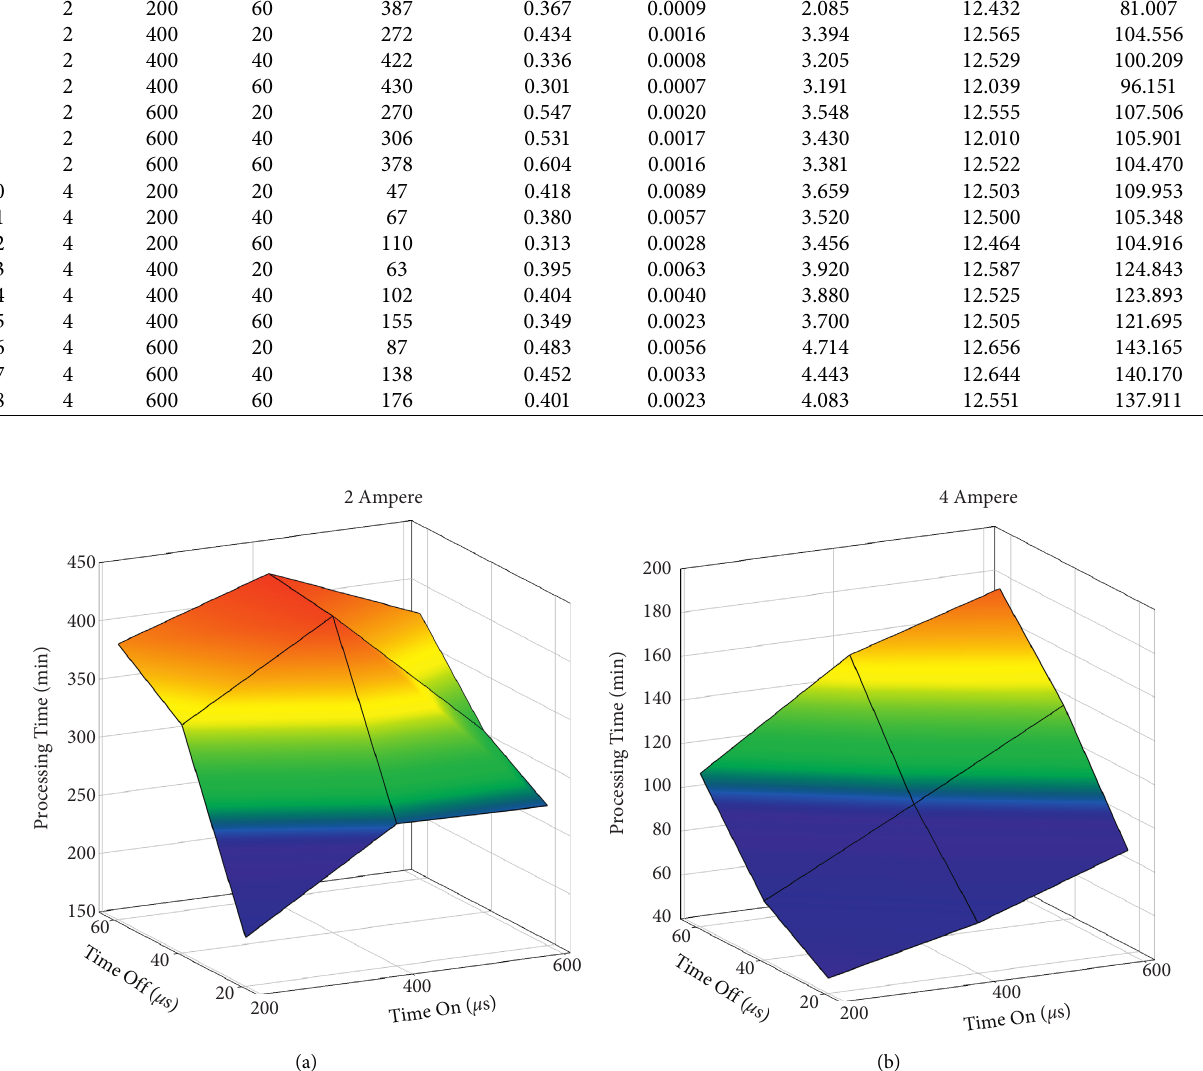
Figure 3: Effect of pulse time-on and time-off on processing time at 2 (a) and 4 (b)